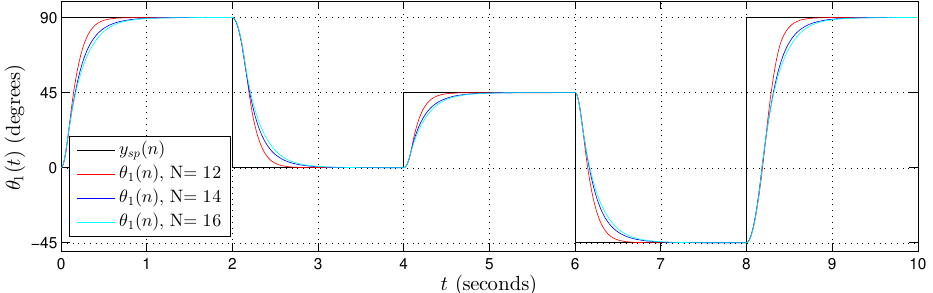
Figure 22. Validation results from the proposed Takagi–Sugeno Fuzzy-PI hardware. Simulation trajectory for θ 1 ( t ) with θ 1 ( n ) using N = { 12,14,16 } bits in the fractional